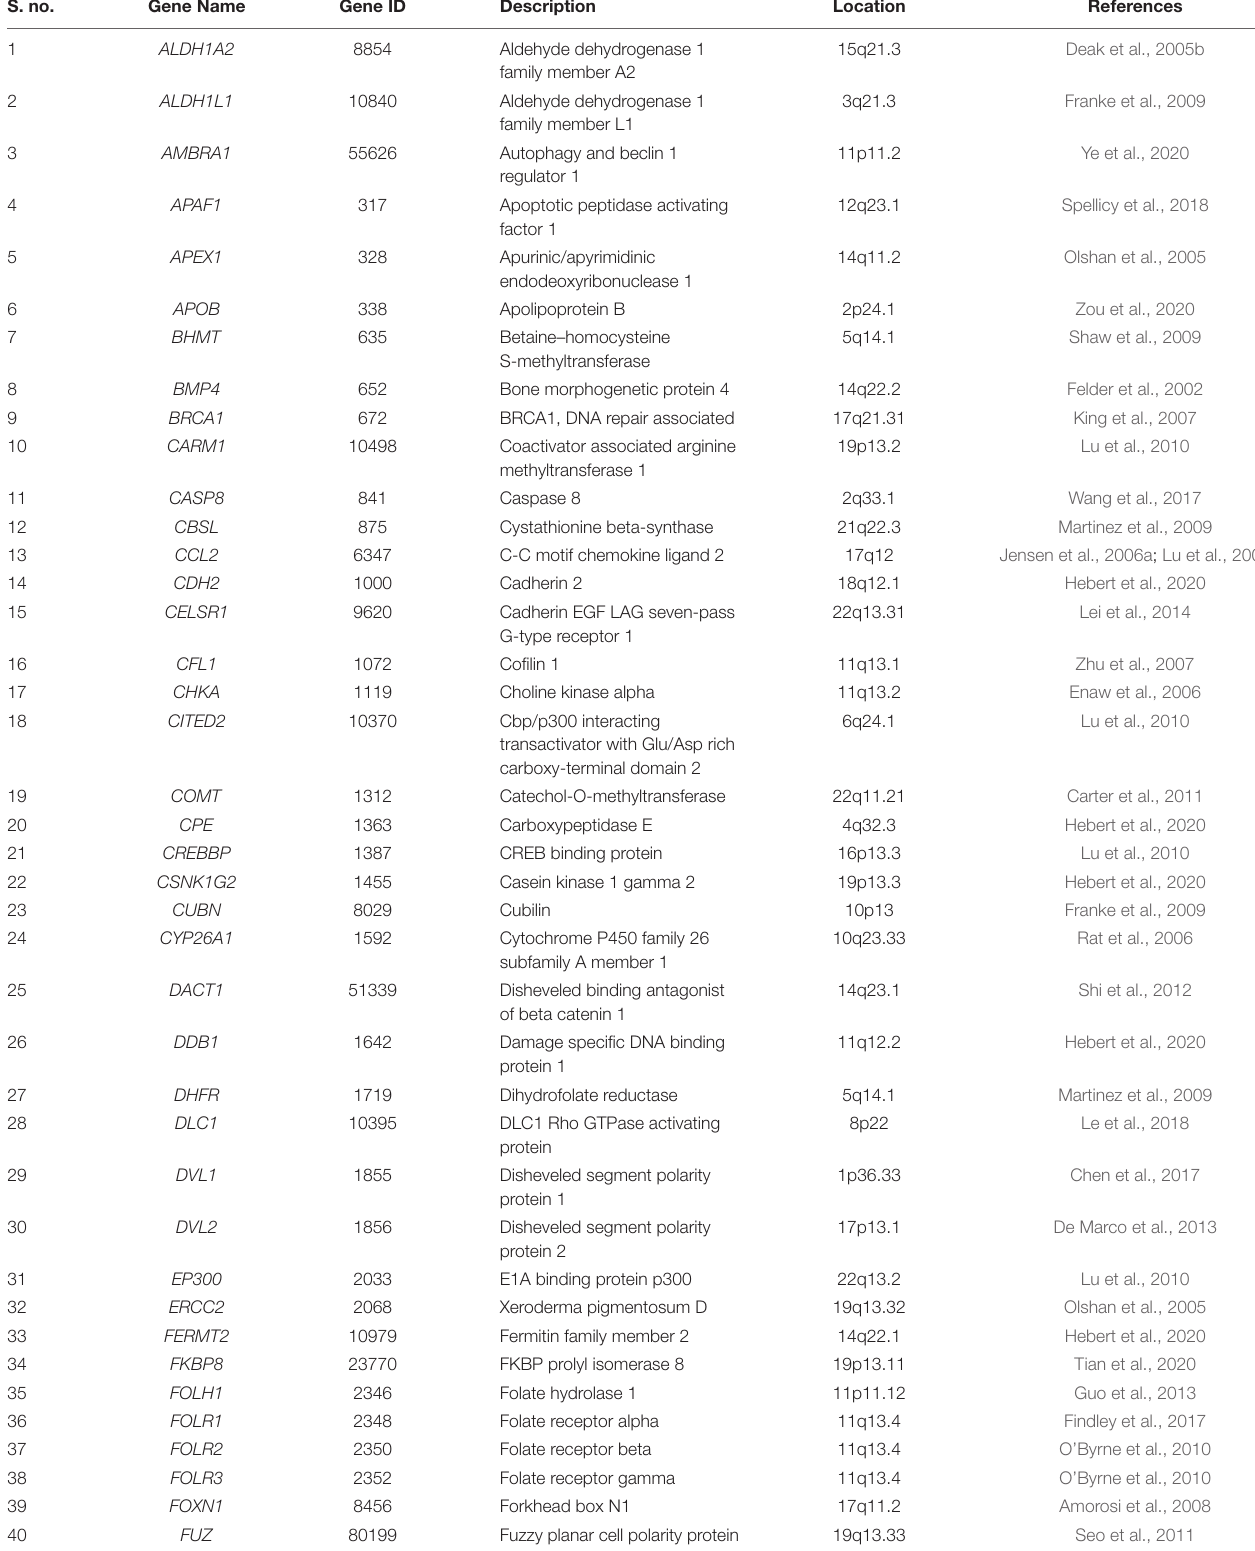
TABLE 1 | List of genes reported as risk factors for SB in humans. S.